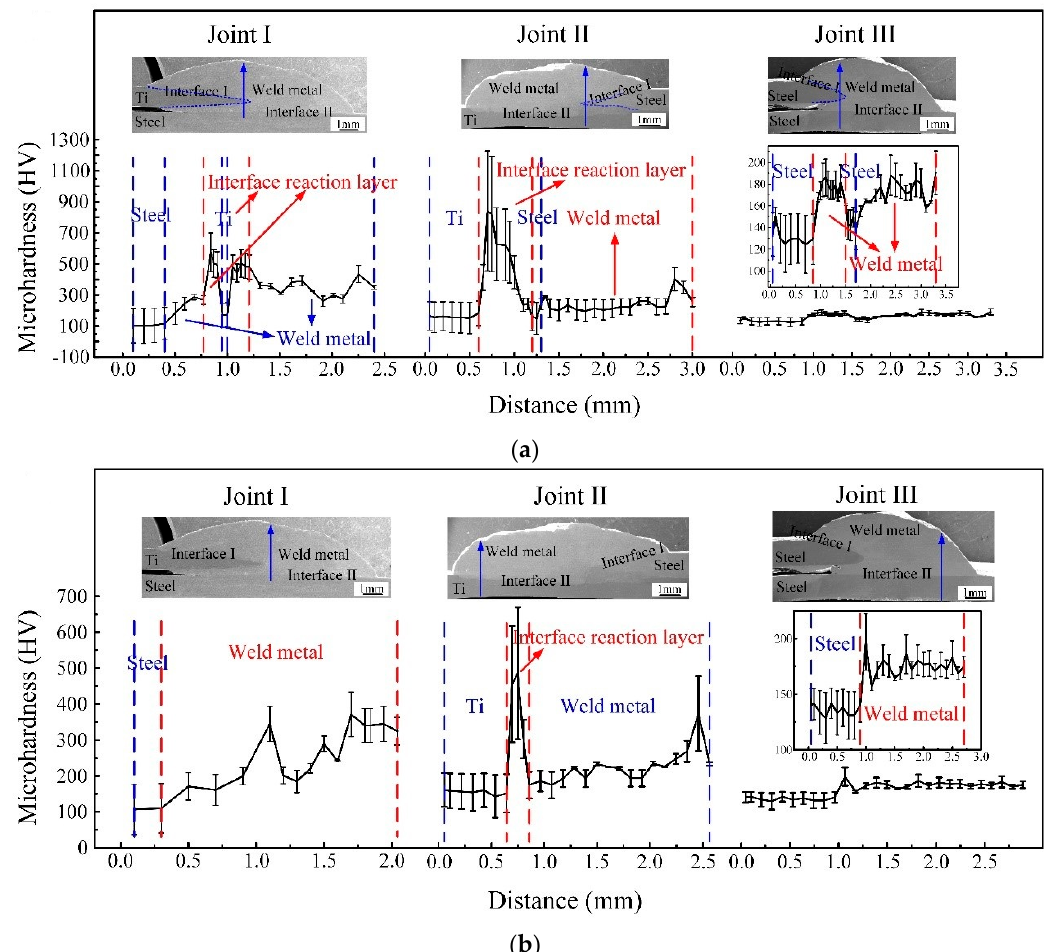
Figure 8. The micro-hardness variation diagram ( a ) along blue arrow in the cross section of Joint I (sample #1), Joint II (sample #2), and Joint III (sample #3), respectively and ( b ) from base metal to interface II to weld metal of Joint I (sample #1), Joint II (sample #2), and Joint III (sample #3), respectively.